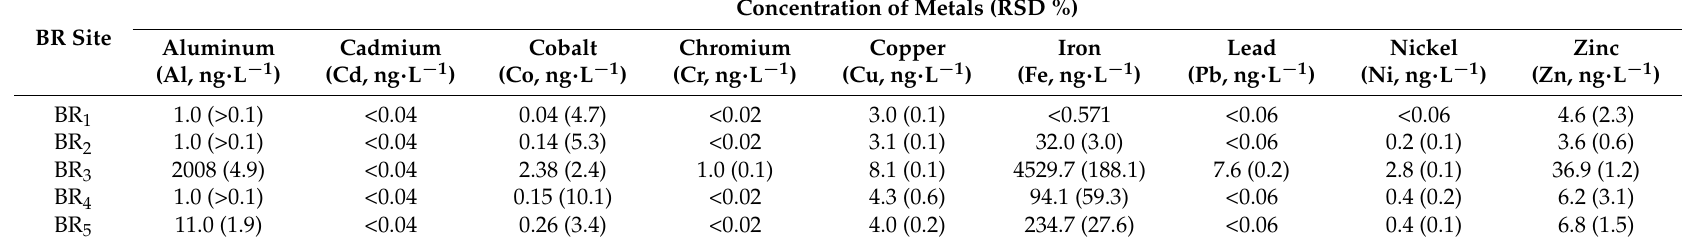
Table 3. Concentrations of metals in the water sourced from different sites and attributed to different sources. Values in the parenthesis denote standard deviations between the samples ( n = 9).